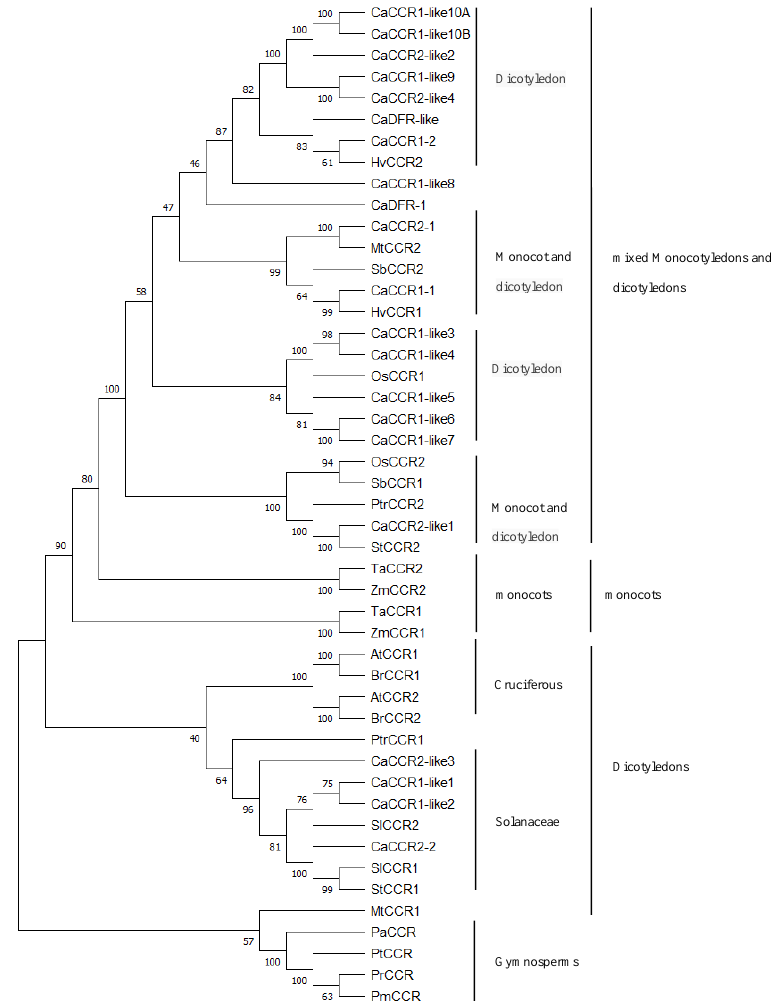
Figure 3. Phylogenetic tree analysis of CCR and CCR-like gene family protein sequences from Capsicum annuum L. and other species. A. thaliana CCRs ( AtCCR1 , AAG46037; AtCCR2 , AAG53687); Hordeum vulgare ( HvCCR1 , XP_044948571.1; HvCCR2 , KAE8782947.1); Zea mays (